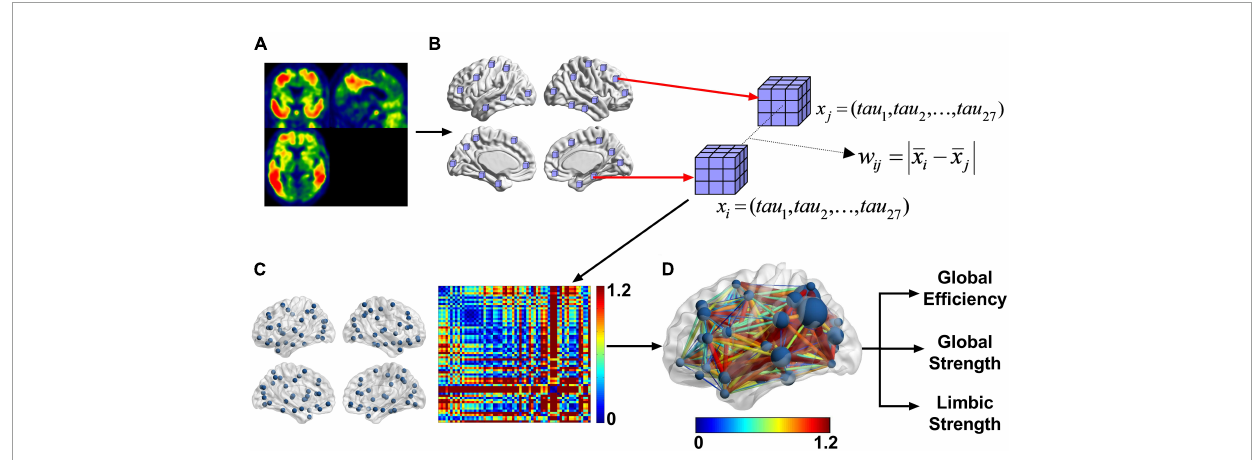
FIGURE2 After preprocessing the PET images (A) into template space, we took 6 mm × 6 mm × 6 mm cubes centered at each of the AAL regions (B) . From that we calculated the difference between the mean tau SUVR of each cube. This resultant matrix is shown as a heatmap (C) . This is a weighted undirected network. The image in panel (D) is another representation of the weighted undirected matrix with the graph on the brain and the color representing the difference of regional tau SUVR. The size of the node is the strength. Each subject in this cross-sectional study had a graph for FTP and from that graph the global strength, global efficiency, and limbic strength can be calculated. Limbic strength is the strength over the bilateral parahippocampal and amygdala nodes.